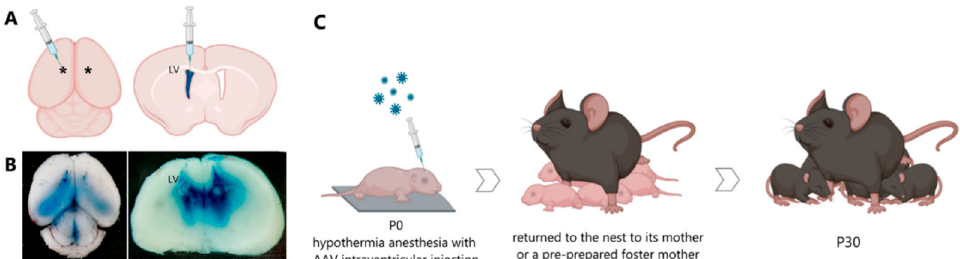
Figure 9. AAV intraventricular injection of neonatal mice (P0). Diagrammatic view of mouse brain shows the target sites (*) which were used for viral injection ( A ). Neonatal whole brain with coronal cross-section of brain harvested immediately after bilateral dye injection to illustrate the extent and localization of the fill ( B ). Scheme of AAV intraventricular injection ( C ). Created in BioRender.com (accessed on 26 May 2022).